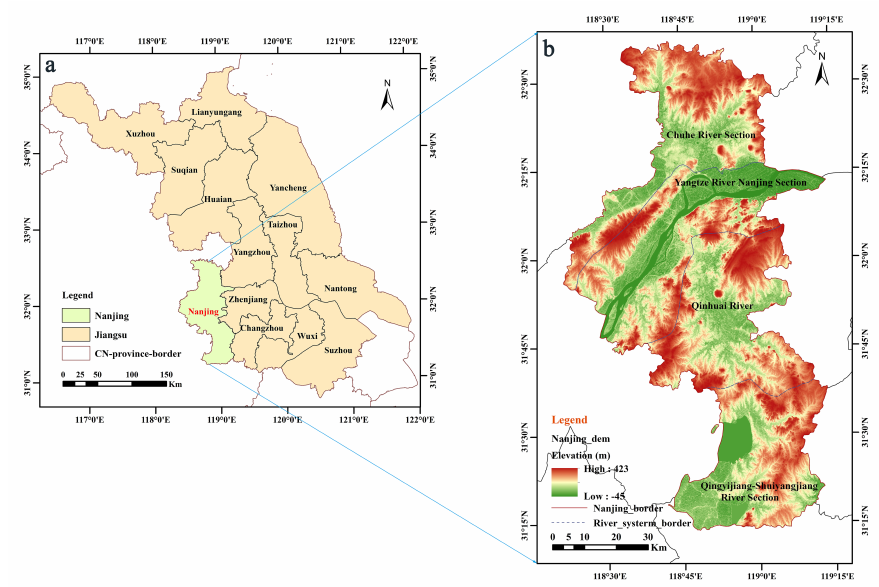
Figure 1. An overview of the study area: ( a ) the location of Nanjing in China; ( b ) digital elevation model (DEM) and divided water system of the study area. Shuttle Radar Topography Mission (SRTM) data source: http: // srtm.csi.cgiar.org.